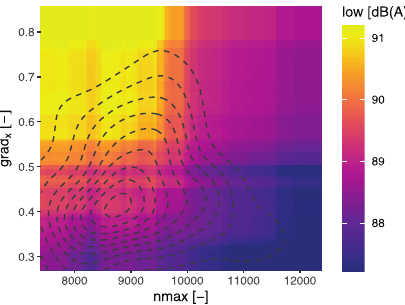
Table 4. Reevaluation performance parameters for the full random forest model based on texture parameters: mean absolute deviation (MAD), root mean squared error (RMSE) and coef fi cient of determination ( R 2 ) for the three frequency